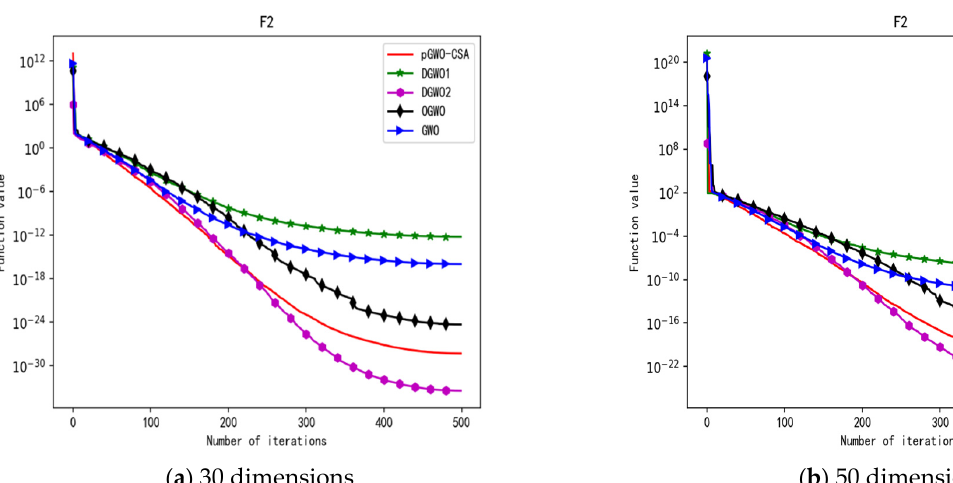
Figure 21. Convergence curve of test function F2.